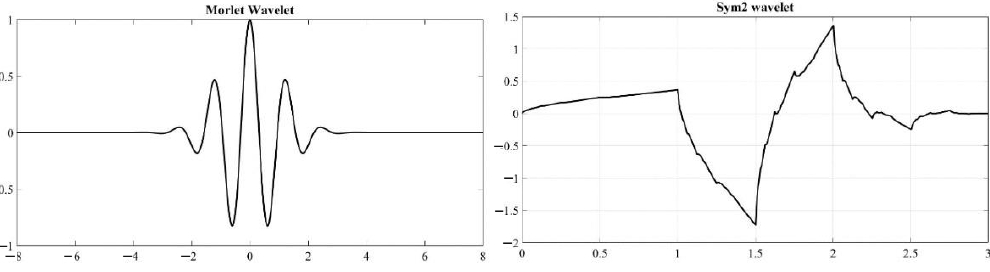
Figure 6. Wavelet function of Morlet and Sym2 wavelet.